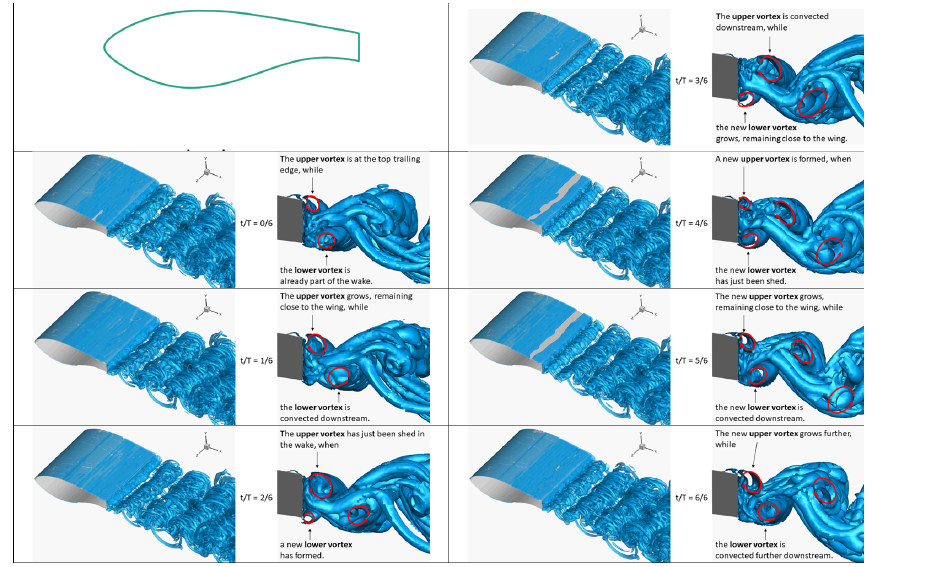
Figure A1. Snapshots of Q isosurfaces from the plain airfoil case: IDDES fine-mesh results. Each period of the vortex shedding mechanism is split into six parts, and a total of seven snapshots is shown. For each snapshot, two visualisations are shown. A 3D view of Q = 1 . 5 isosurfaces is shown on the left, and a side view of Q = 100 isosurfaces is shown on the right. Superimposed red arrows indicate interpreted spanwise vortices.